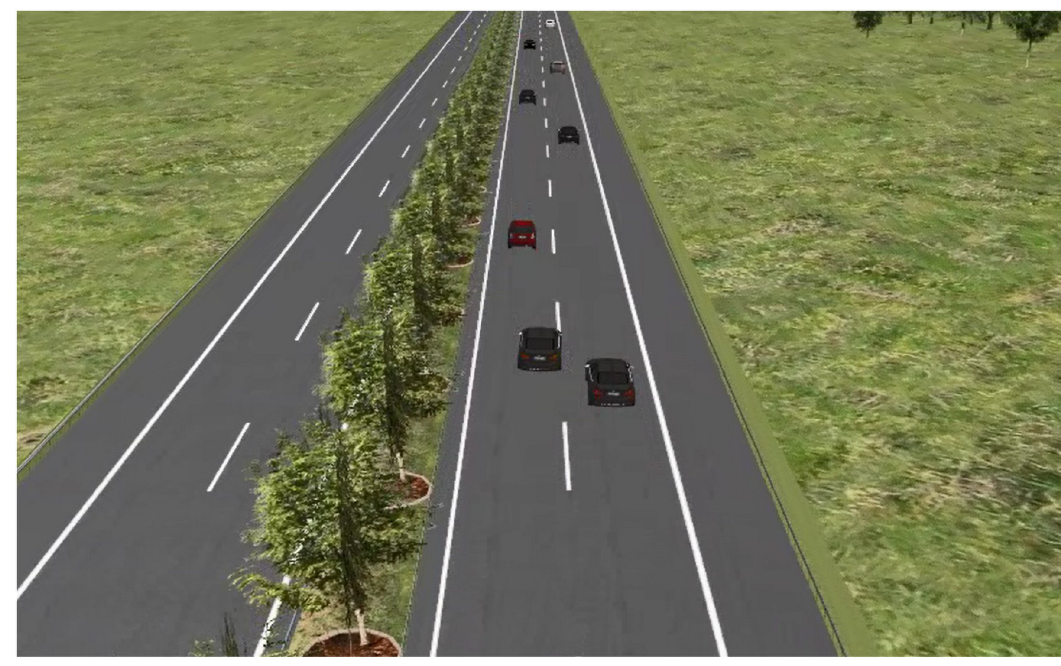
Fig 12. Video of the time of risk driving.